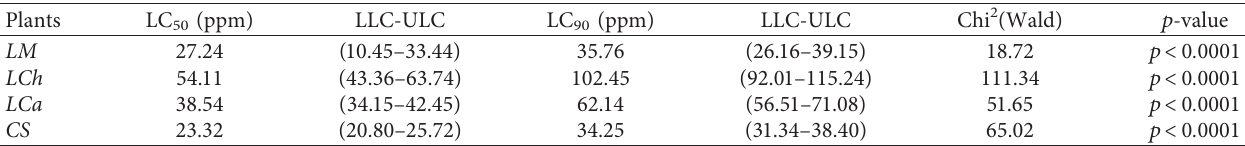
Table 4: The 50% and 90% lethal concentrations (LC 50 and LC 90 , respectively), their 95% confidence intervals, and regression parameters of the larvicidal activity of essential oils against Culex quinquefasciatus 24h post treatment. Plants LC 50 (ppm)